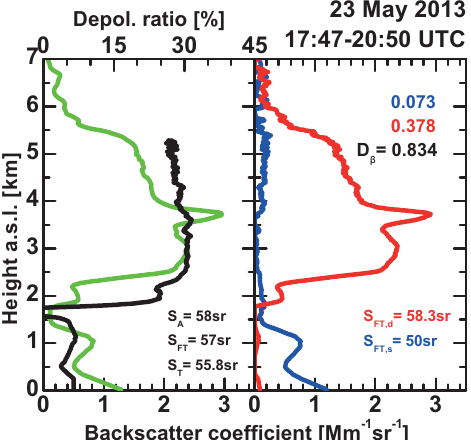
Figure 11. Mean profiles (3-h average) of the 532nm particle backscatter coefficient (left, green), particle linear depolarization ratio (left, black), dust backscatter coefficient (right, red), and non-dust particle backscatter coefficient (right, blue). The elastic- backscatter lidar method (explained in Sect. 3) is applied to the same observation as shown in Fig. 10. Retrieved column lidar ra- tios for the total troposphere ( S T ), the free troposphere ( S FT ), and derived from the AERONET data ( S A for the 13:00–14:00UTC pe- riod) for the total tropospheric column after Schuster et al. (2012) are given as numbers in the left panel. S PBL of 30sr is assumed for the height range up to 500m. The retrieved dust-related lidar ratio S FT,d and the assumed non-dust lidar ratio ( S FT,s ) are given in the right panel together with the dust AOT (red number), non-dust AOT (blue number) for the total troposphere, and the FT dust backscatter fractions D β (column dust backscatter to total particle backscatter in the free troposphere above 500m height). Again, the relative un- certainty in the particle backscatter coefficient and depolarization ratio is 10%, and of the order of 20% for the dust-related backscat- ter coefficient (Mamouri et al.,